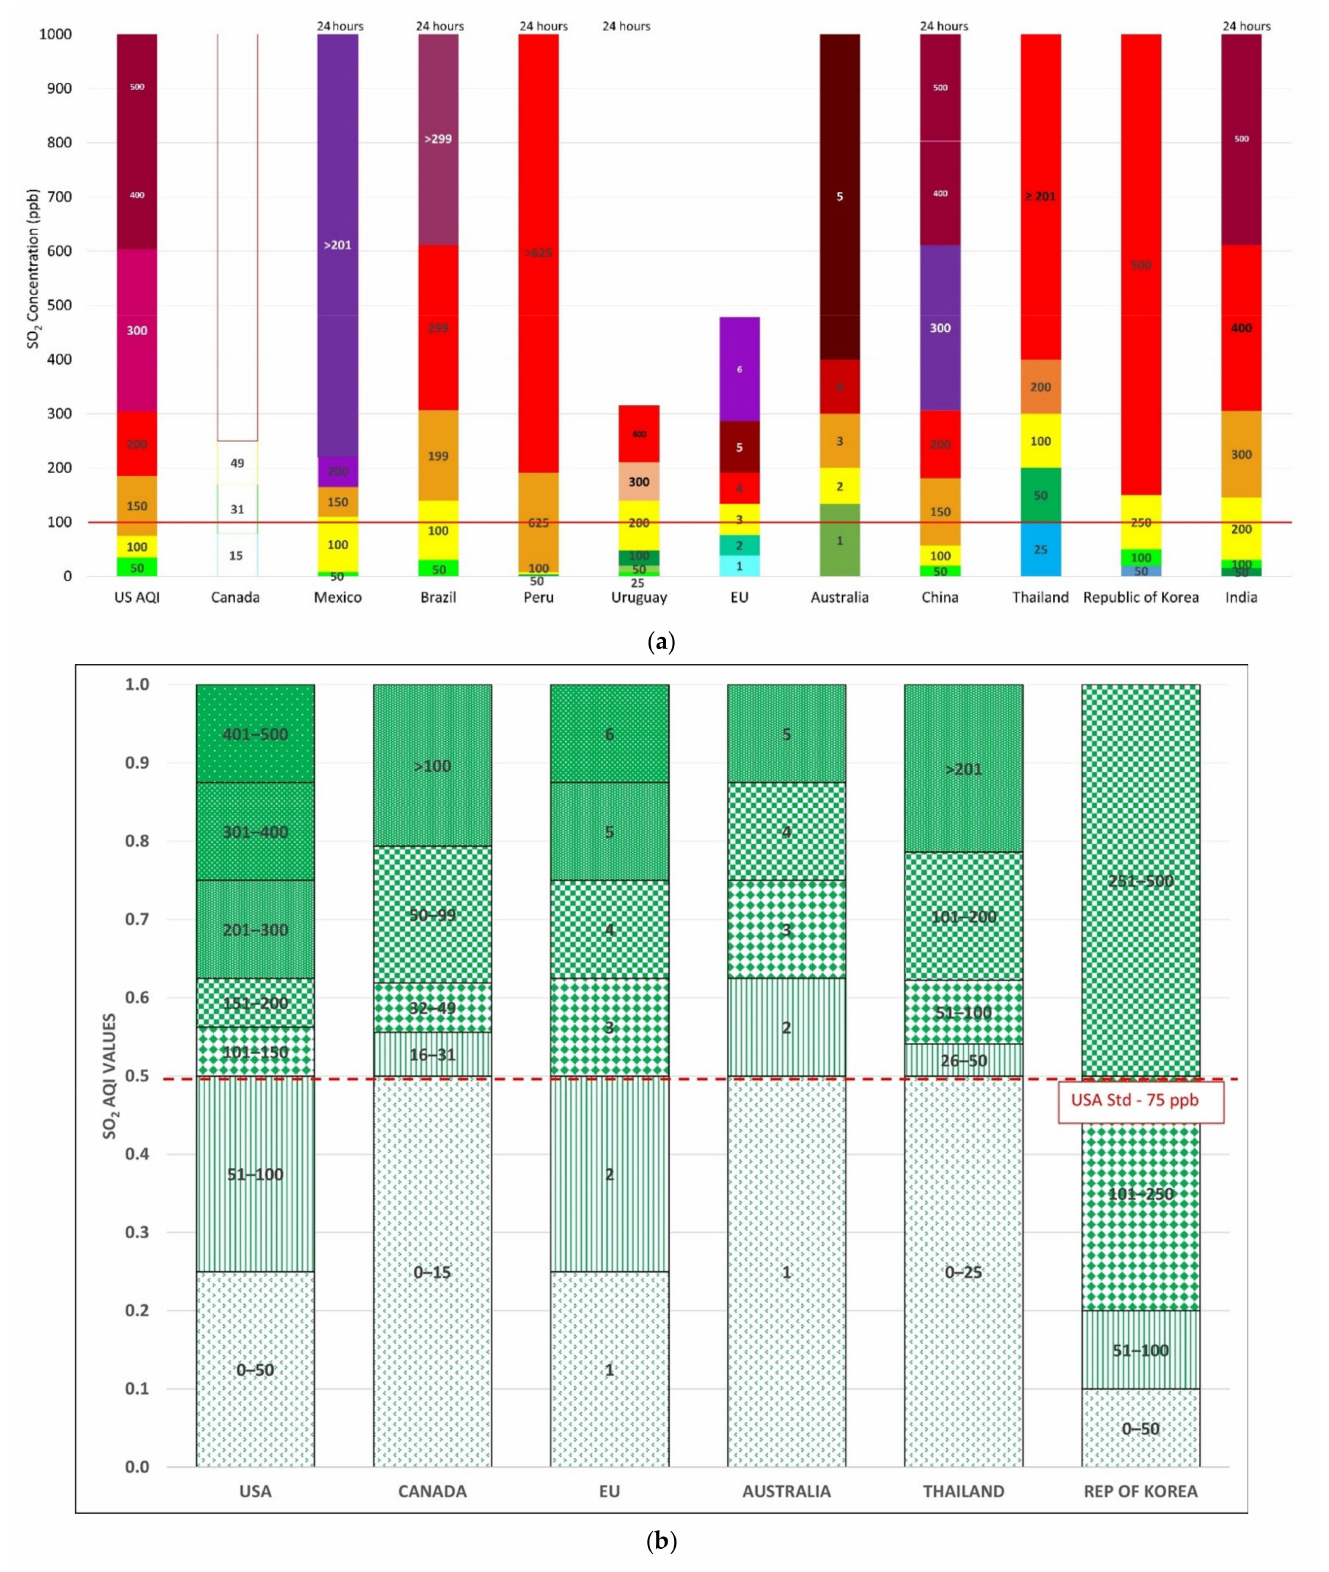
Figure 2. ( a ) SO 2 concentration corresponding to AQI classes in different countries (above the bars, the daily averaging periods when applied). The red line represents the USA standard value. ( b ) Normalized SO 2 AQI values (based on 1-h averaged